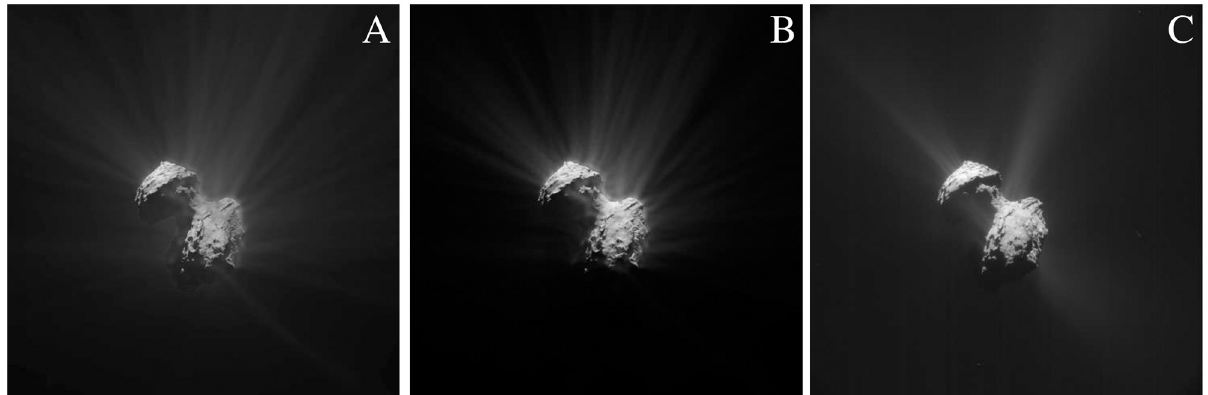
Fig 9. Comet 67P/C-G with coma. (A) OpenGL, (B) Cycles and (C) Real image. The brightness was enhanced at the post-processing stage in order to better visualise coma.